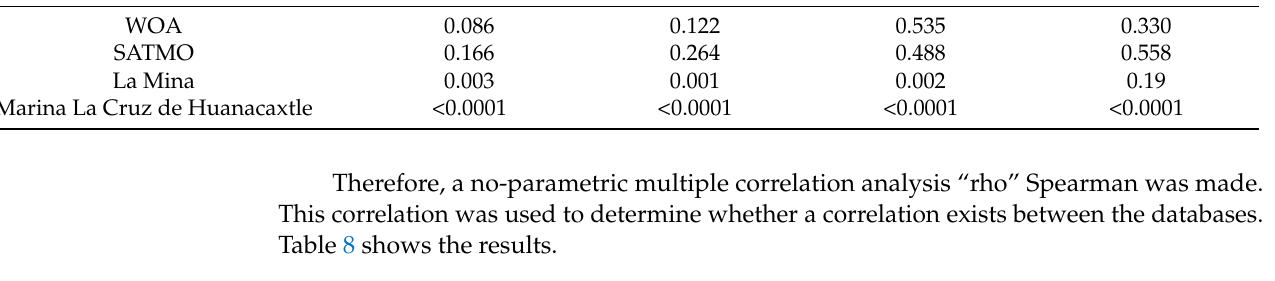
Table 8. Values of the multiple correlation factor (rho) for the three databases